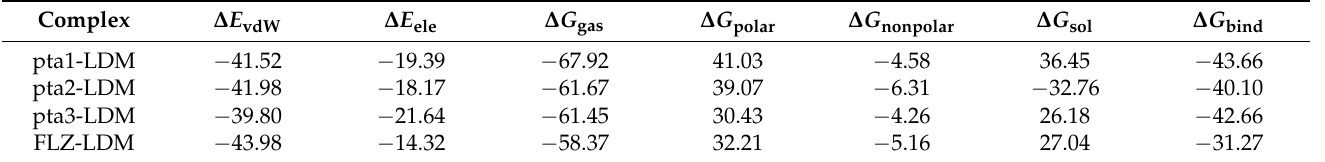
Table 1. MM/GBSA-based binding energy profile of LDM enzyme in complex with pta1, pta2, pta3, and fluconazole